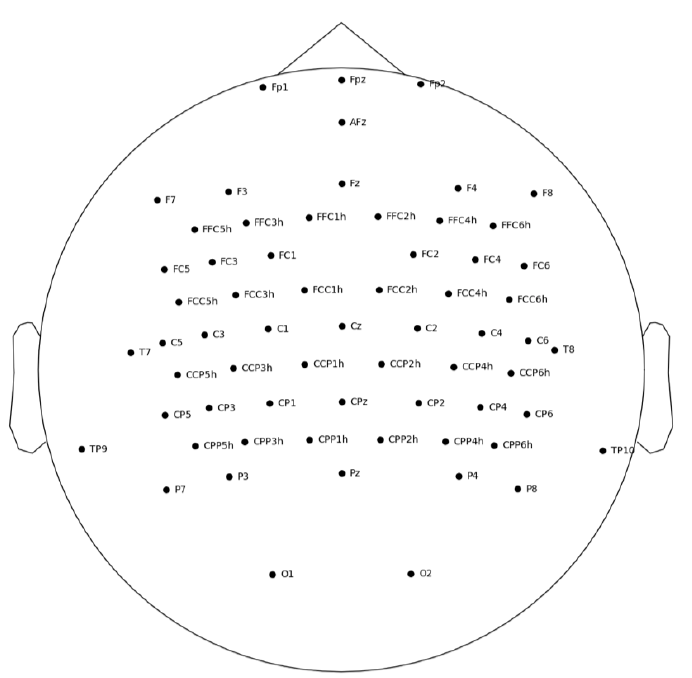
Figure A1. EasyCap 64-channel layout, with additional electrodes over the motor